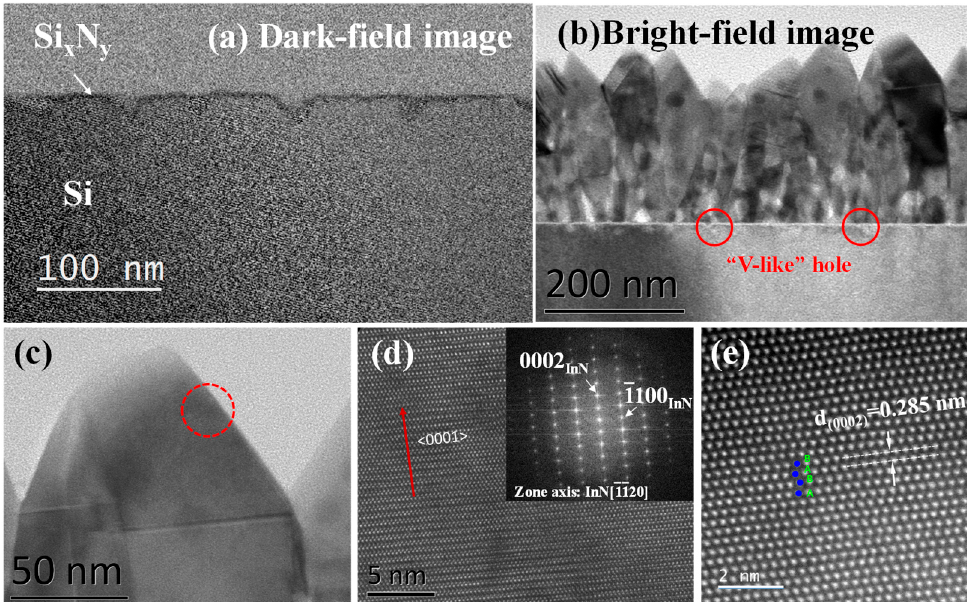
Figure 3. ( a ) Cross-sectional bright-field TEM (XTEM) image of nitrided Si(111). ( b ) XTEM image of InN nanocolumns grown on a nitrided Si(111) substrate. ( c ) XTEM image of the top of a InN nanocolumn. ( d ) High-resolution scanning electron microscopy (HRTEM) image of the area in c indicated by the red dashed circle. The inset in d shows the FFT pattern of the wurtzite InN nanocolumn. ( e ) HRTEM lattice image of the area in d indicated by the red arrow.